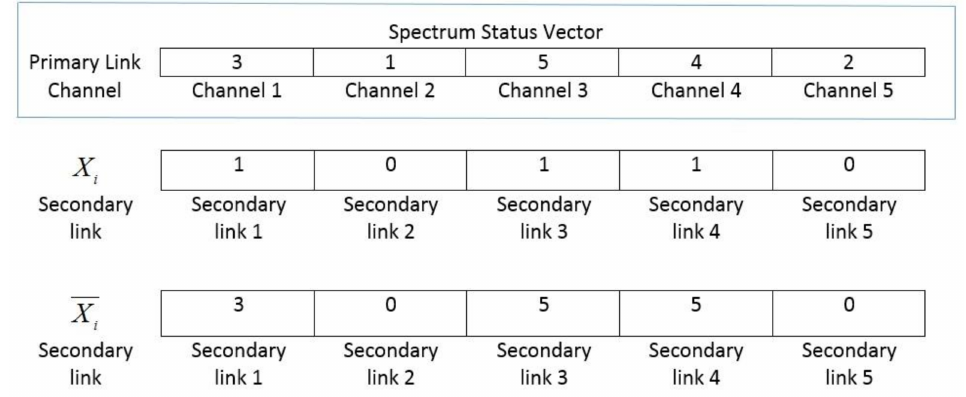
Figure 2. Illustration of the spectrum status vector and X ib , X (cid:48)